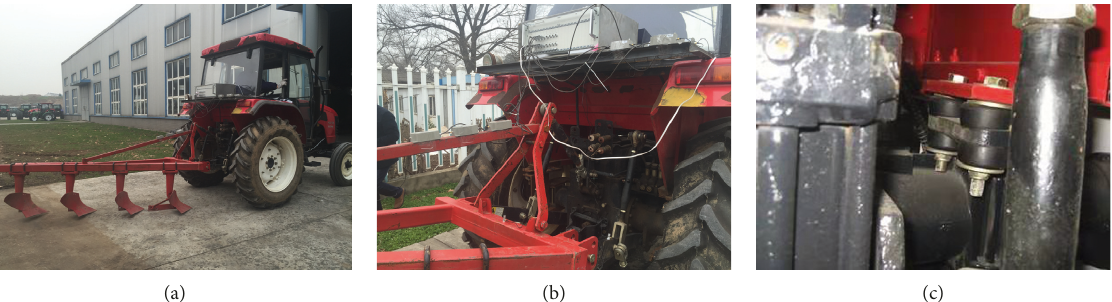
Figure 2: Physical structure of the tractor system: (a) tractor/implement system; (b) three-point hitch structure; (c) silent blocks of cabin.